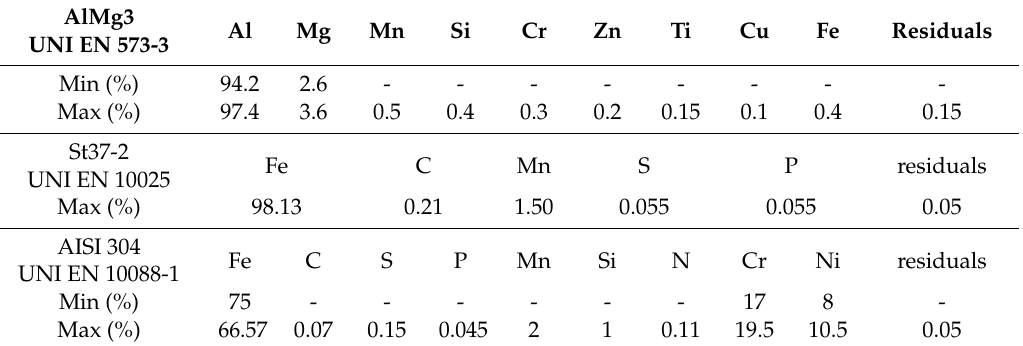
Table 1. Chemical composition of the adopted materials.